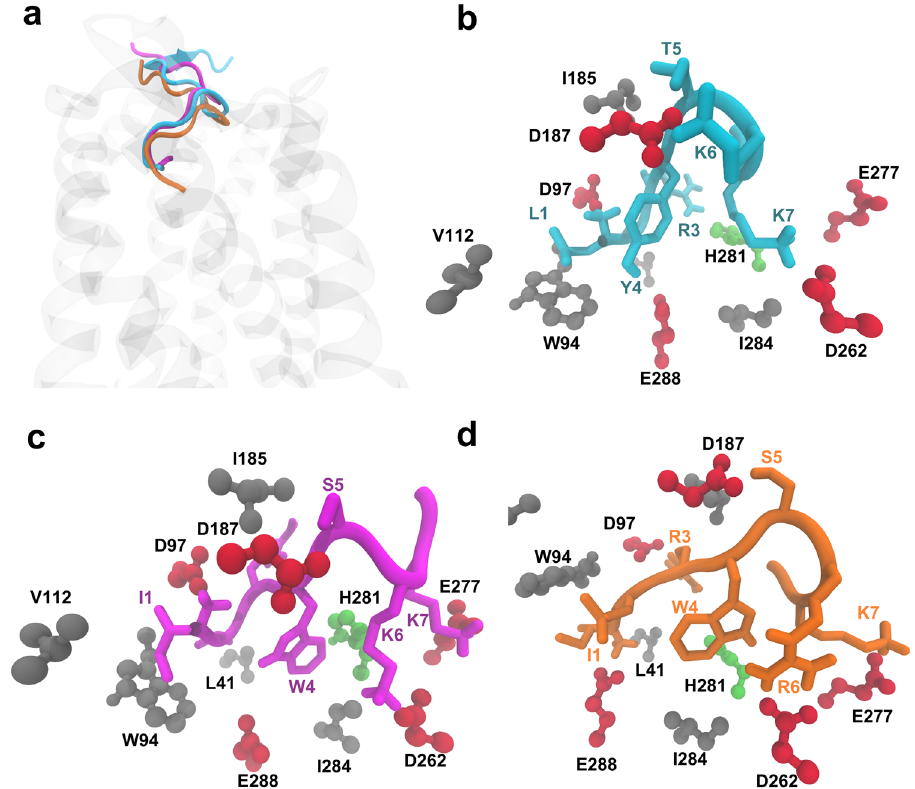
Fig. 5 Comparison of the binding modes of EPI-X4 (cyan), WSC02 (purple), and JM#21 (orange). a The position of the three peptides in the binding pocket, b EPI-X4, c WSC02, and d JM#21 (CPK representation of CXCR4 residues by type: acidic residues = red, polar uncharged = green, nonpolar residues =